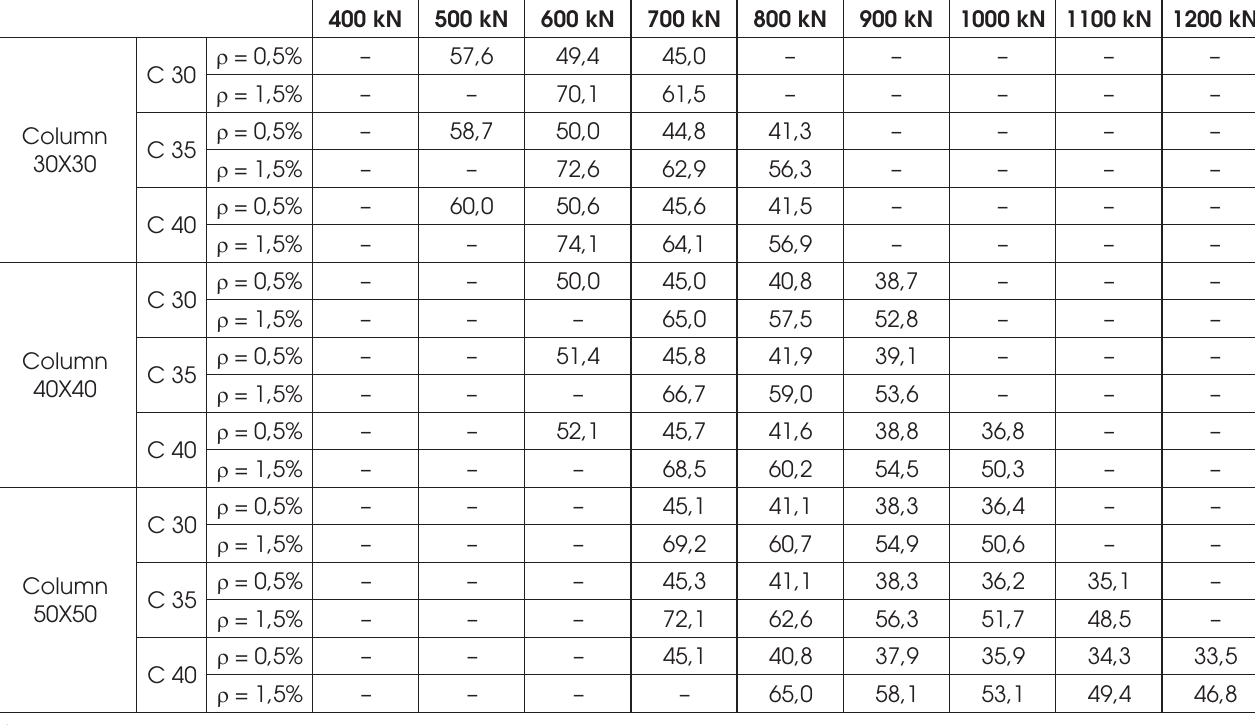
Percentual reduction by Comparison 5, considering s